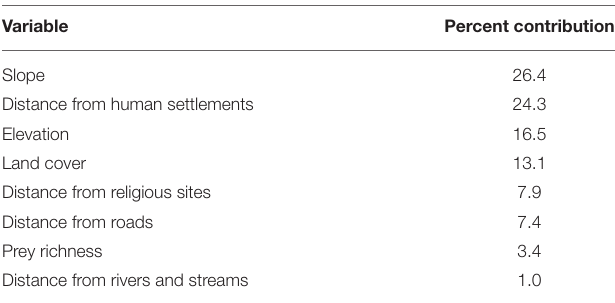
TABLE 4 | Relative contributions of the input variables to the MaxEnt model of dhole ( Cuon alpinus ) distribution/habitat suitability in Bhutan.